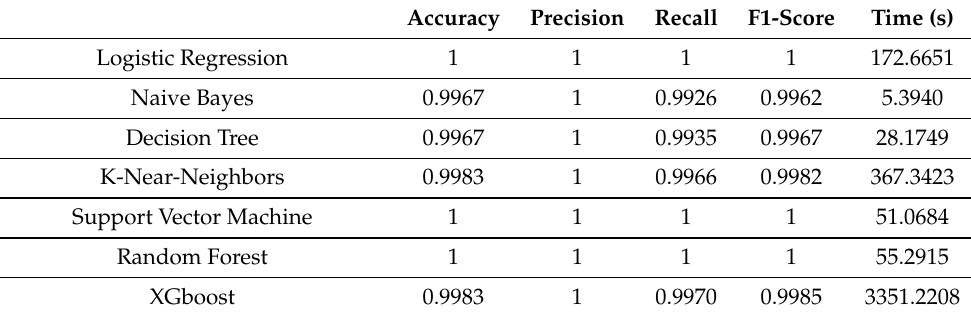
Table 3. Detection performance of two SH IoT devices triggered